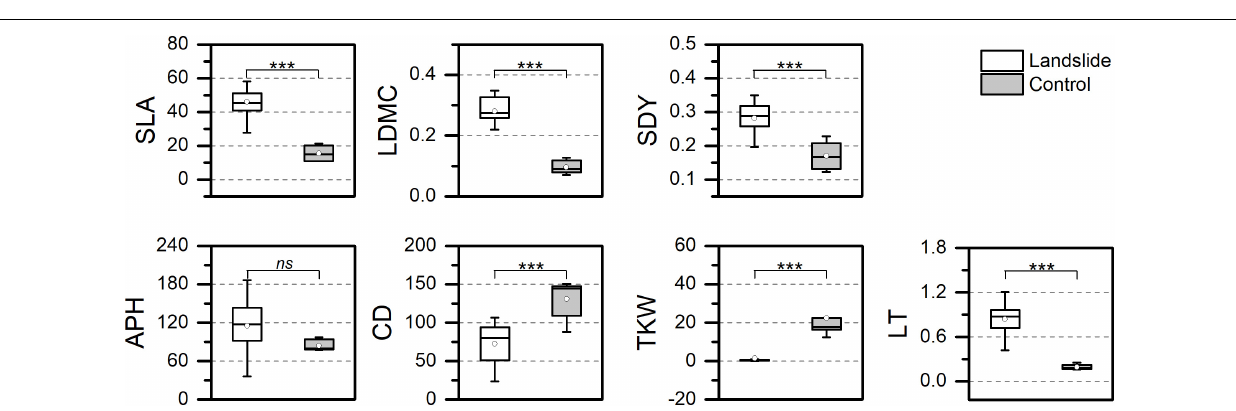
FIGURE 3 | The difference in community functional traits of woody plants between landslide and non-landslide sites. SLA, specific leaf area; LDMC, leaf dry matter content; SDY, stem density; LT, leaf thickness; APH, average plant height; CD, crown diameter; TKW, thousand kernel weight; ns, non-significant; ***, significant at the 0.01